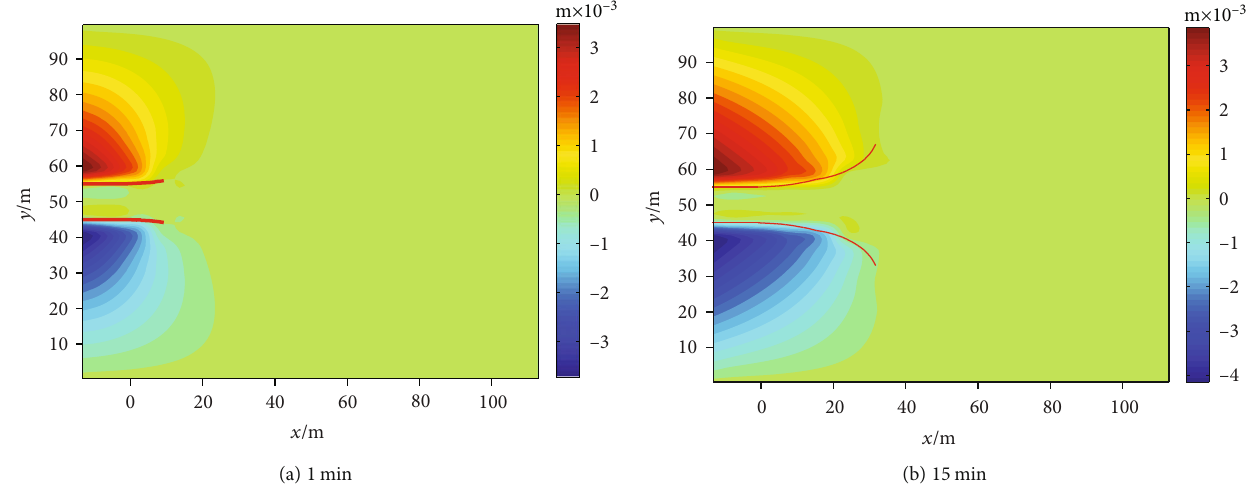
Figure 9: Displacement distributions of simultaneous propagation in single well.